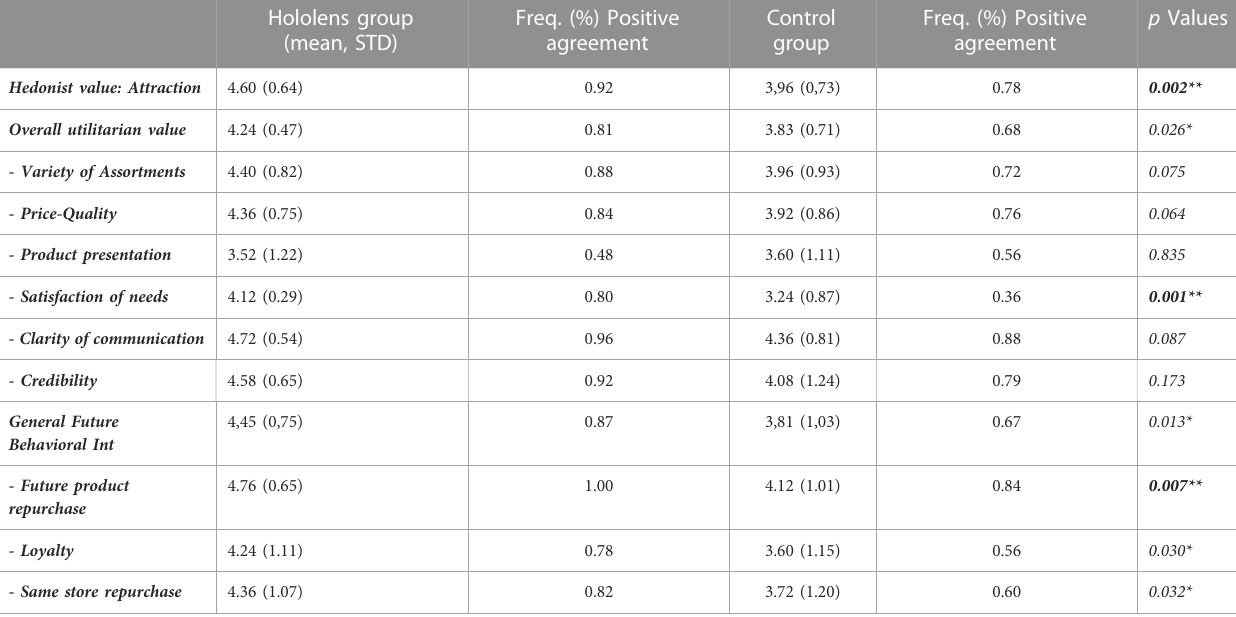
TABLE 7 Scores of participants ’ explicit evaluation of the overall shopping